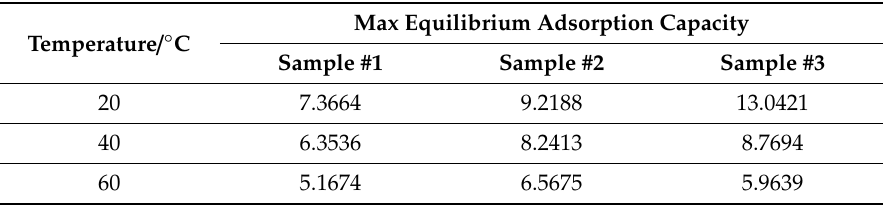
Table 4. The equilibrium adsorption capacities at relative humidity (RH) 90% of samples #1, #2, and #3. Max Equilibrium Adsorption Capacity Temperature/°C Sample #1 Sample #2 Sample #3